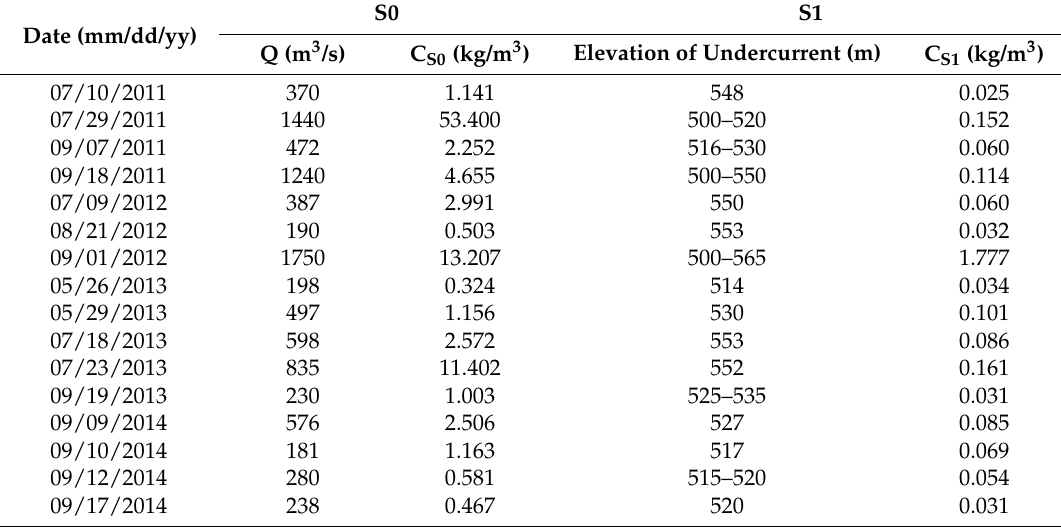
Table 1. Inflow peak discharge and measured inflow suspended sediment concentration (C S0 ) at S0, and elevation of undercurrent and measured suspended sediment concentration (C S1 ) at S1 from 2011 to